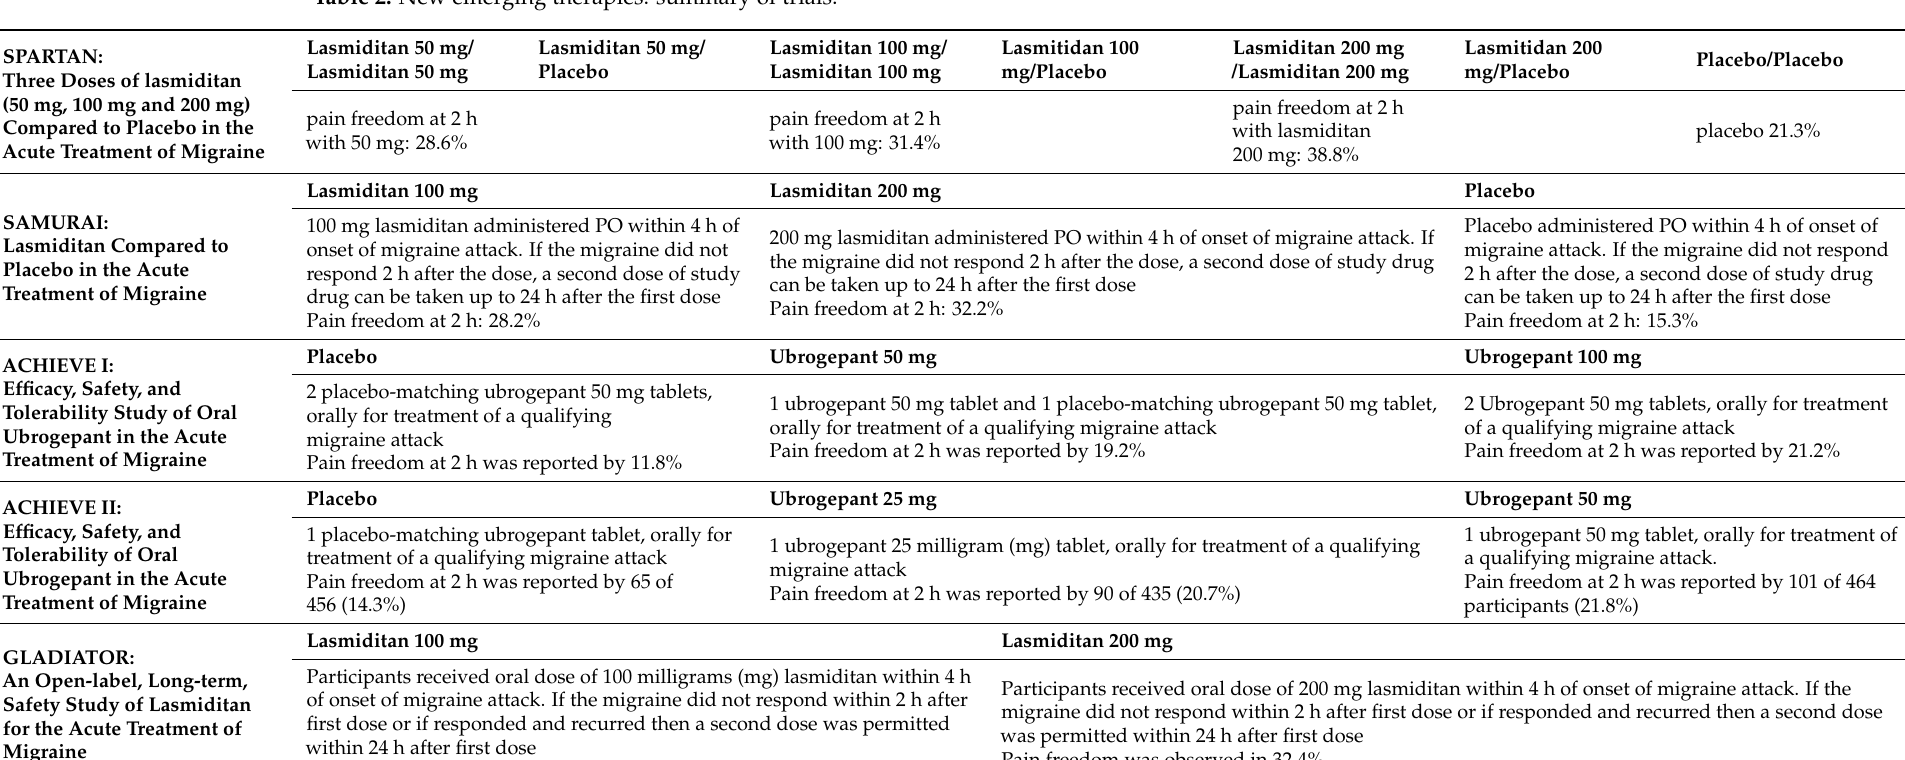
Table 2. New emerging therapies: summary of